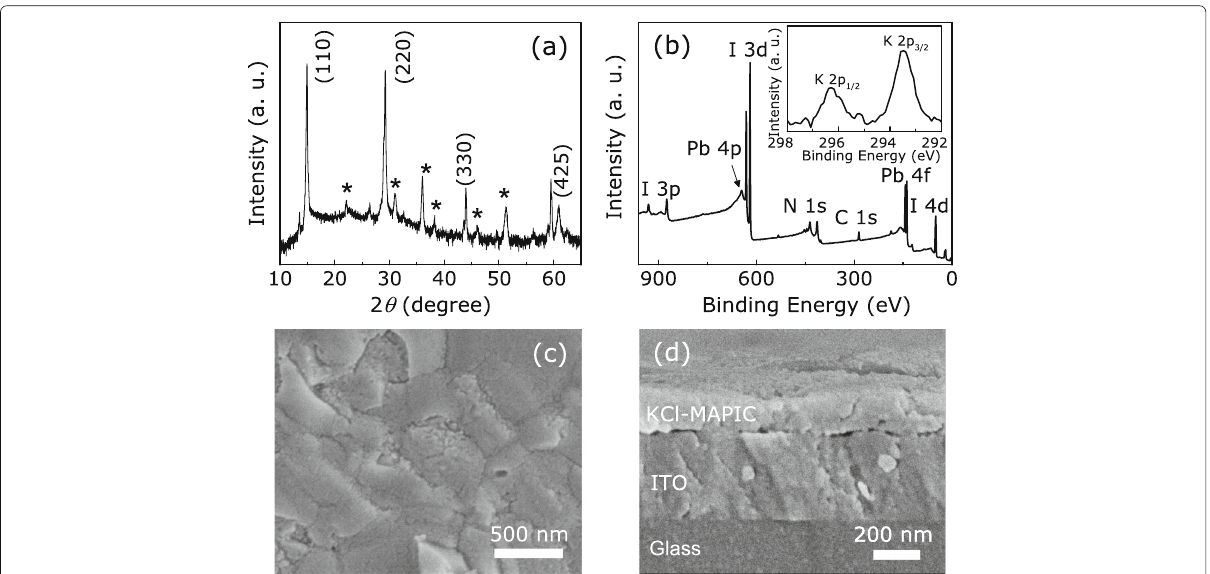
Fig. 2 a XRD spectrum of the as-prepared KCl-doped MAPIC films on the ITO-coated glass substrate. (cid:3) represents peaks of the ITO/glass substrate. b XPS wide spectrum of the perovskite films. The inset displays the core-level XPS spectrum of K. c The top-view and d the cross-section SEM images of KCl-MAPIC layers formed on the ITO/glass substrate